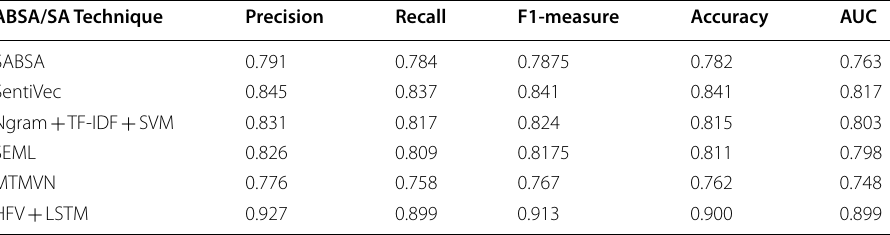
Table 5 Comparison of HFV LSTM Model using STS-Gold data set with State-of-the-Art Methods + ABSA/SA